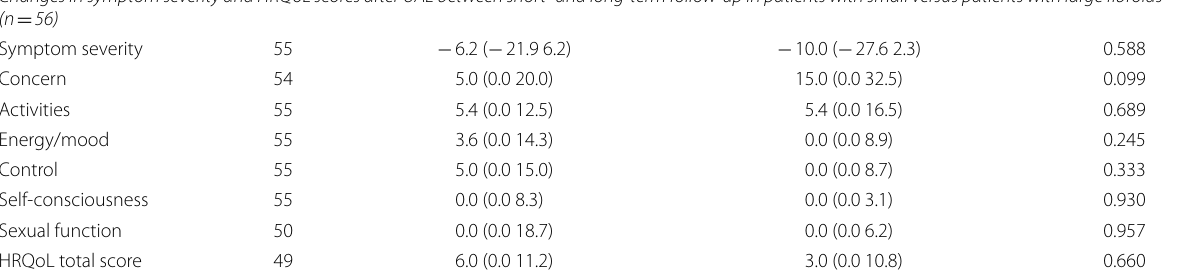
(1) n Number of patients with sufficient answered questions for the calculation of transformed scores using the ‘UFS-QoL Scoring =